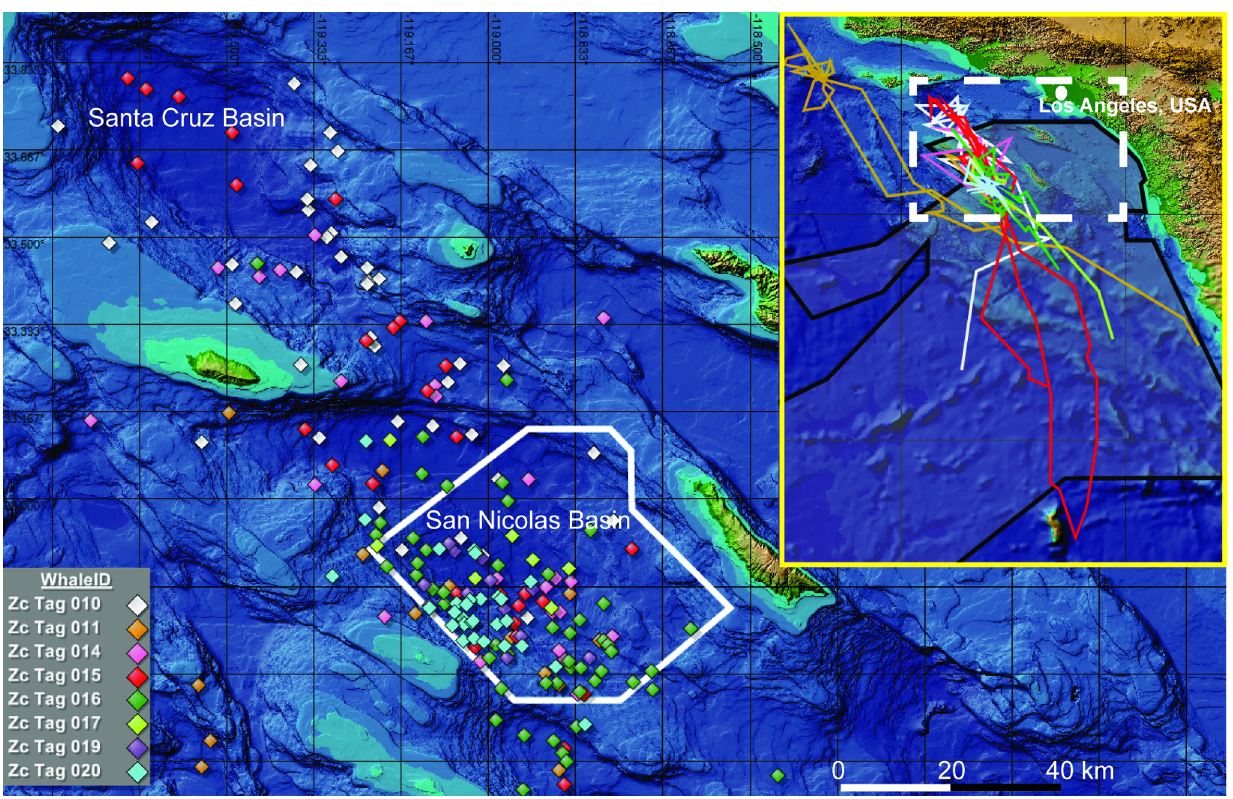
Figure 1. Map of the study area displaying one daily position estimate of each tagged whale. All eight whales were tagged within the Southern California Anti-submarine Warfare Range (outlined in solid white). Tagged whales were within the San Nicolas Basin for 51% of all days tags transmitted, and within the SOAR boundaries for 71% of the days when in the basin, suggesting site fidelity to the MFA sonar training range. Inset map shows the entire track-line of each tagged whale with the primary map region indicated by a dashed box. The SOCAL Range Complex, which encompasses all areas of authorized MFA sonar use [6], is lightly shaded and outlined in black in the inset map. Map created using Mysticetus Observation System, v1.8.0.124 (Entiat River Technologies, Preston, WA,